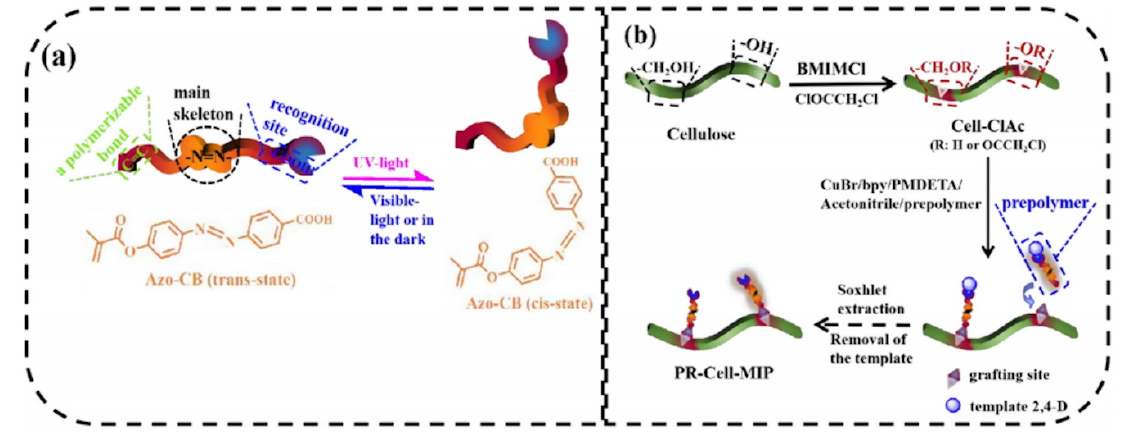
Figure 7. Schematic illustrations for ( a ) photo-responsive properties of the Azo-CB functional monomer and ( b ) synthesis route of PR-Cell-MIP. Reproduced from the work in [73] with permission from Elsevier.